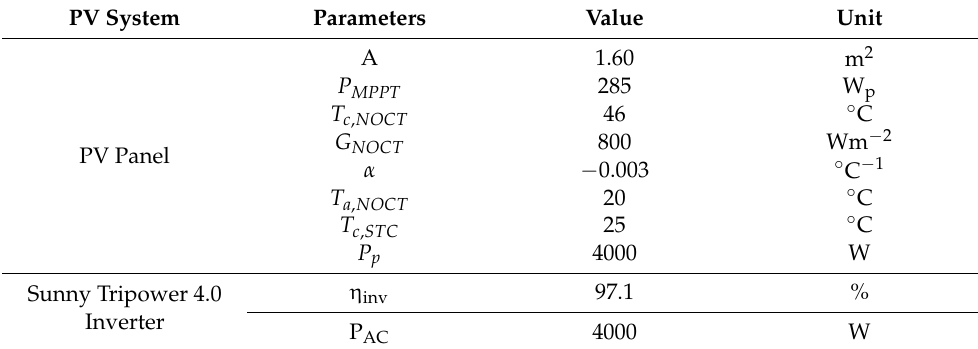
Table 2. PV model & Inverter parameters used for the reference system with 4 kWp. Table 6. Scenario summary. Table 6. Scenario summary.